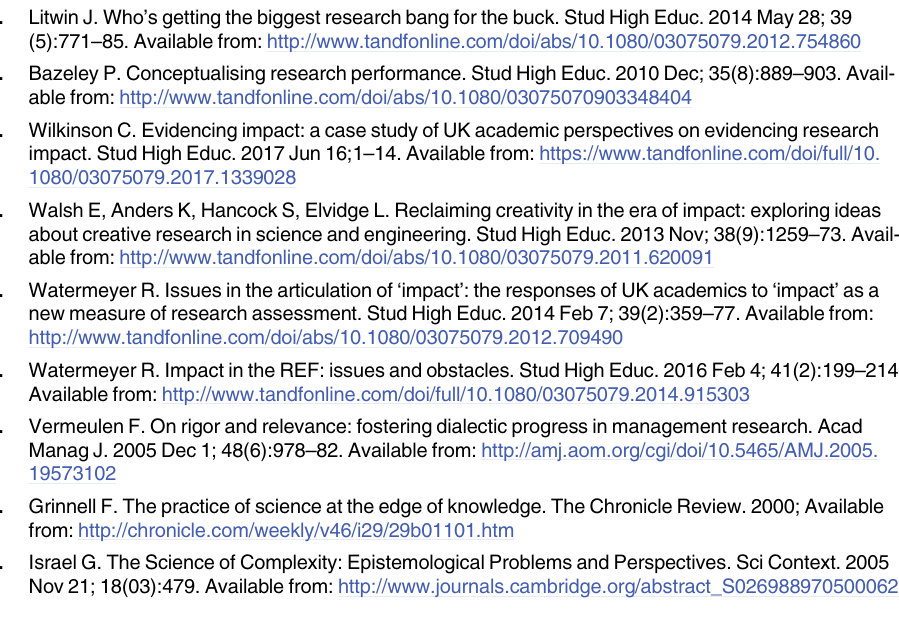
S1 Table. Detailed responses to the questionnaire, percentages of responses per concepts.